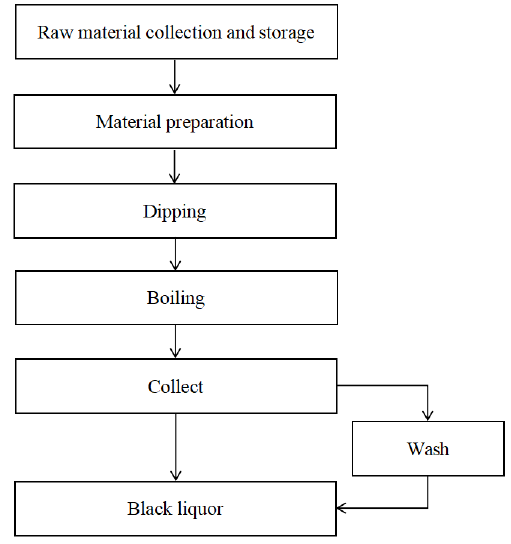
Figure 12. Flow chart of black liquid production.